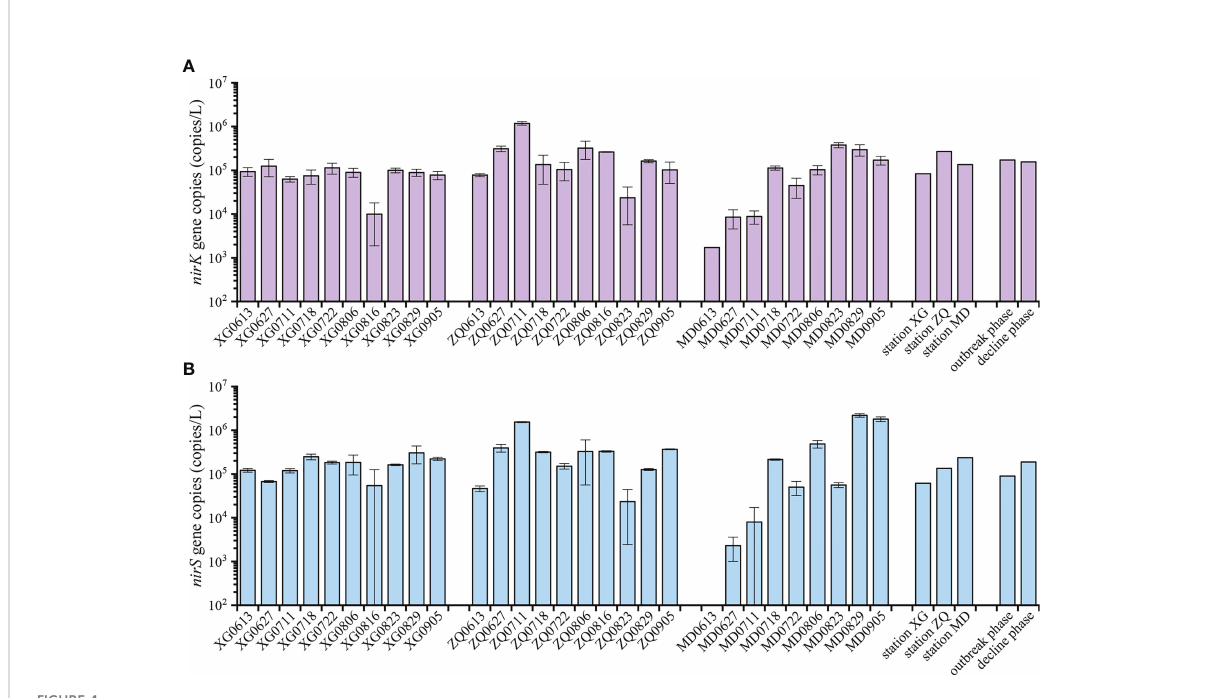
FIGURE 4 Quantitative analysis of the nirK (A) and nirS (B) genes during the green tide in coastal Qingdao